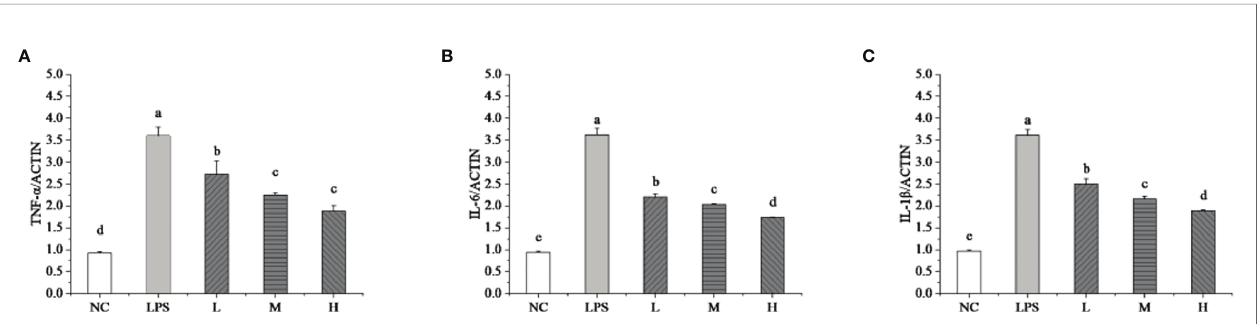
FIGURE 2 | Effect of L. plantarum KLDS 1.0344 on the expression levels of cytokine genes in bMEC. (A) TNF- a ; (B) IL-6; and (C) IL-1 b . NC represents unstimulated bMEC; LPS represents LPS-stimulated bMEC; L, M, and H represent LPS-stimulated bMEC co-incubated with 10 5 , 10 6, and 10 7 CFU/mL L. plantarum KLDS 1.0344, respectively. Values are mean ± SD. Means with no common letters differ signi fi cantly (P <